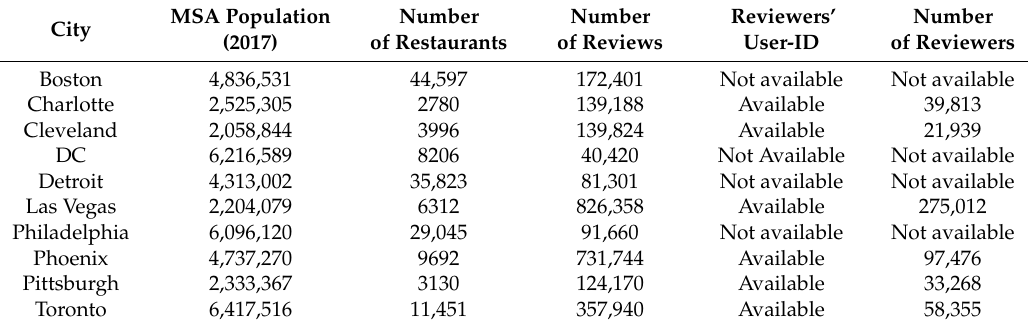
Table 1. Number of reviews and restaurants for the 10 cities.